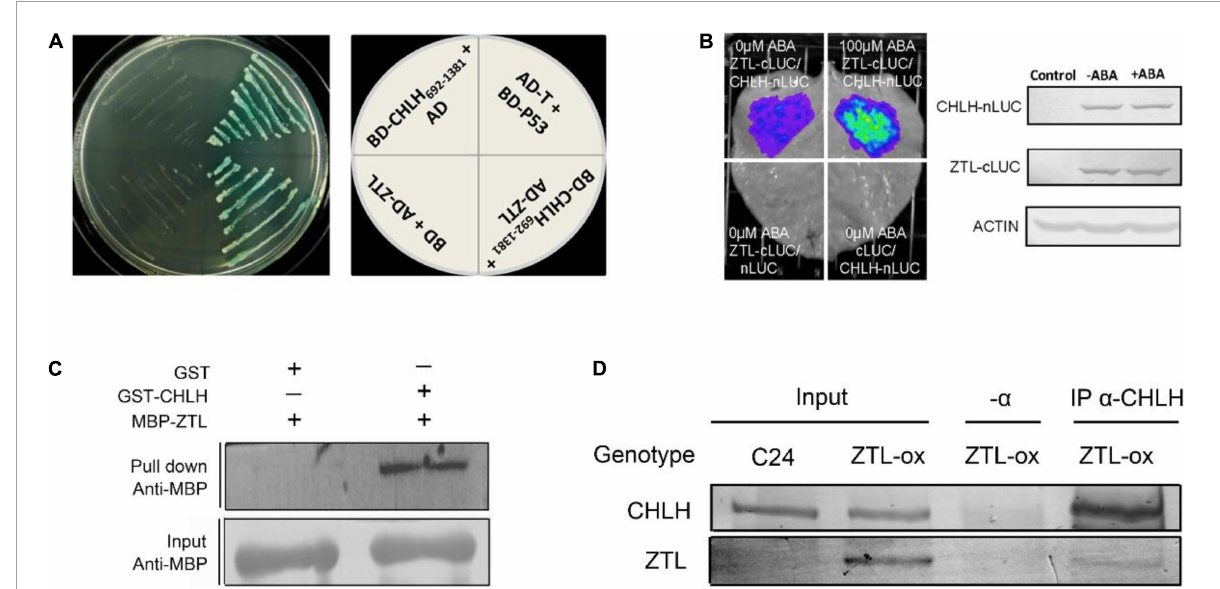
FIGURE1 Molecular interaction between CHLH and ZTL. (A) CHLH interacts with ZTL in yeast. The C-terminus (amino acids 692–1,381) of CHLH was fused to GAL4 DNA binding domain in the plasmid pGBKT7 (BD-CHLH 692 - 1 , 381 ), and the ORF of ZTL was cloned into pGADT7 plasmid (AD-ZTL). BD-p53/AD-T was taken as a positive control. AD/BD-CHLH 692 - 1 , 381 and AD-ZTL/BD were used as negative controls. The experiments were repeated three times with similar results. (B) Firefly luciferase complementation imaging (LCI) assay. CHLH was fused with nLUC (CHLH-nLUC), and ZTL was fused with cLUC (ZTL-cLUC). Tobacco leaves were transformed and treated with 100 µ M ( ± ) ABA for 4 h prior to image recording. ZTL-cLUC/nLUC and cLUC/CHLH-nLUC were used as negative controls. The protein amounts of CHLH-nLUC and ZTL-cLUC in the tobacco leaves with or without ABA treatment described in the experimental group (CHLH-nLUC/ZTL-cLUC), which were detected by immunoblotting using anti-CHLH and anti-cLUC antiserum, respectively. The expression of ACTIN protein was used as an internal control. “Control” indicates leaves without transformation. The experiments were repeated four times with similar results. (C) Pull-down assay showed that CHLH directly interacts with ZTL. The experiments were repeated three times with similar results. (D) Western-blot analysis of protein extracts immunoprecipitated with anti-CHLH antibody ( α -CHLH) and subsequent detection of ZTL-YFP ( α -GFP) protein. The experiments were repeated three times with similar